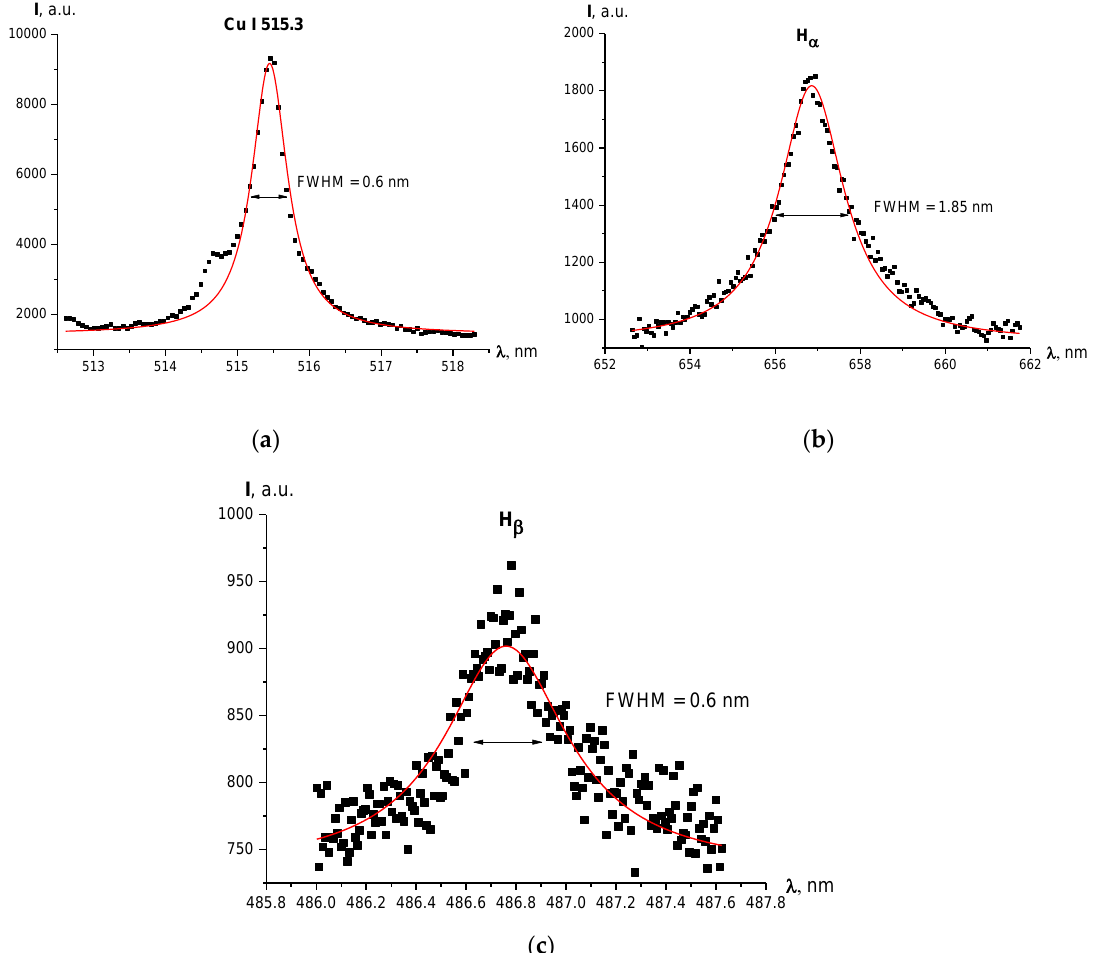
Figure 4. Line profiles and Voigt fit of the registered lines for current regime I = 1000 A, radial position r = 0 mm (discharge axis): ( a ) Cu I 515.3 nm line; ( b ) H α line; ( c ) H β line.